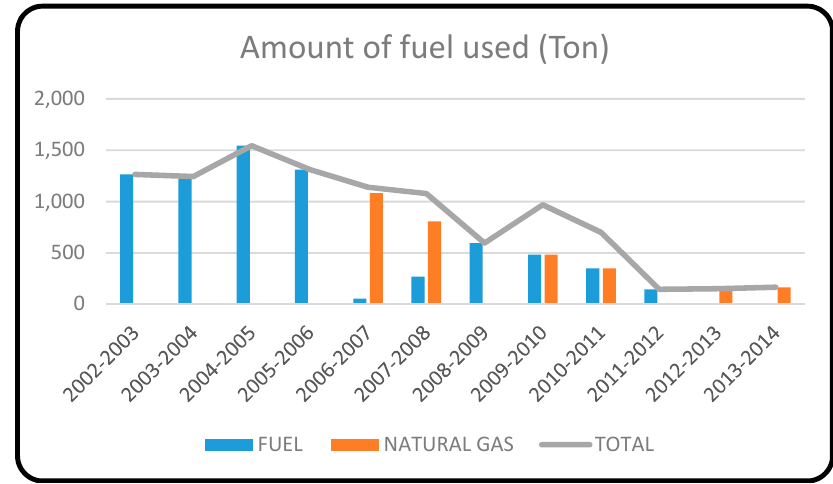
Figure 9. Fuels used in greenhouses. Source: Fieldwork.